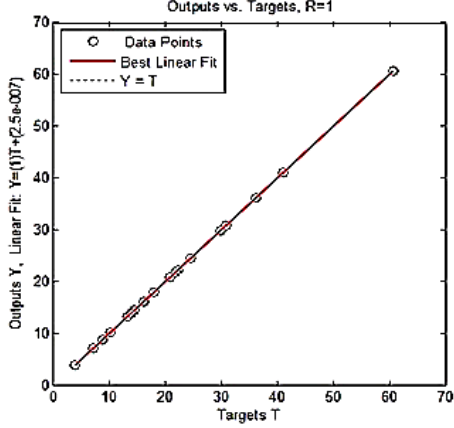
Figure 11. Regression plot of actual and network’s MRR .